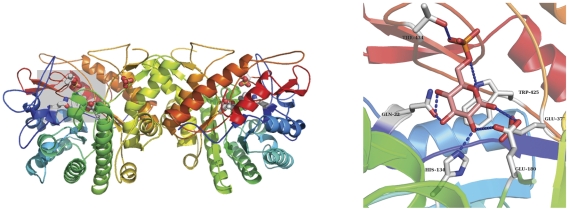
BglA dimer and putative active site.Left, BglA dimer with the putative active site outlined in a gray box. Right, close up of the active site with glucose-6-phosphate modeled based of the position of the sulfate ion from crystallization. Active site residues are depicted as ball-and-stick. Putative hydrogen bonds to the substrate are drawn as dashed lines.